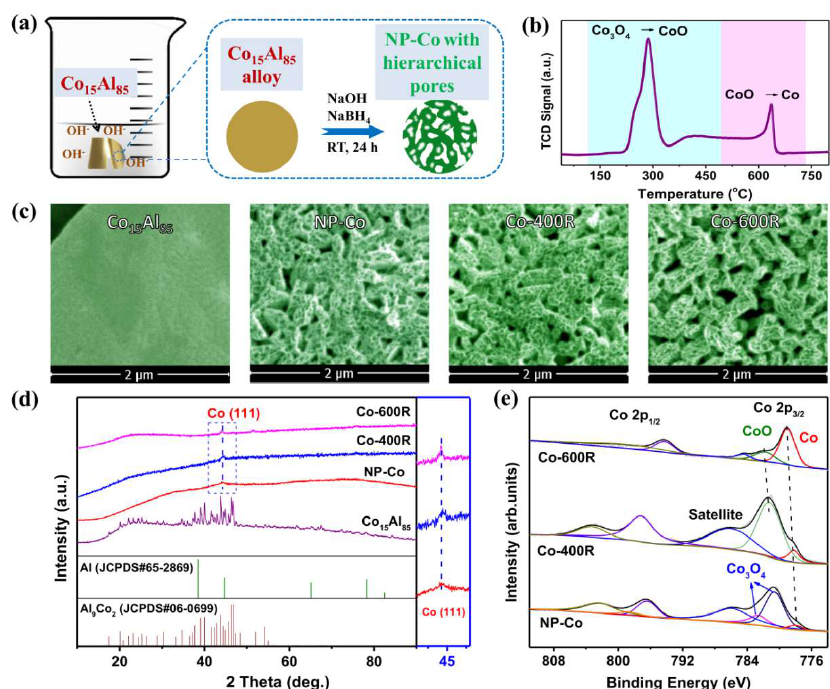
Figure 1. The preparation and characterization of the nanoporous Co (NP-Co) catalysts. ( a ) Illustration of the NP-Co formation process; ( b ) hydrogen temperature-programmed reduction (H 2 -TPR) profile of the fresh NP-Co; ( c ) SEM images; ( d ) XRD patterns; and ( e ) X-ray photoelectron spectroscopy (XPS) spectra of Co 2p of the NP-Co catalysts with different pretreatments.